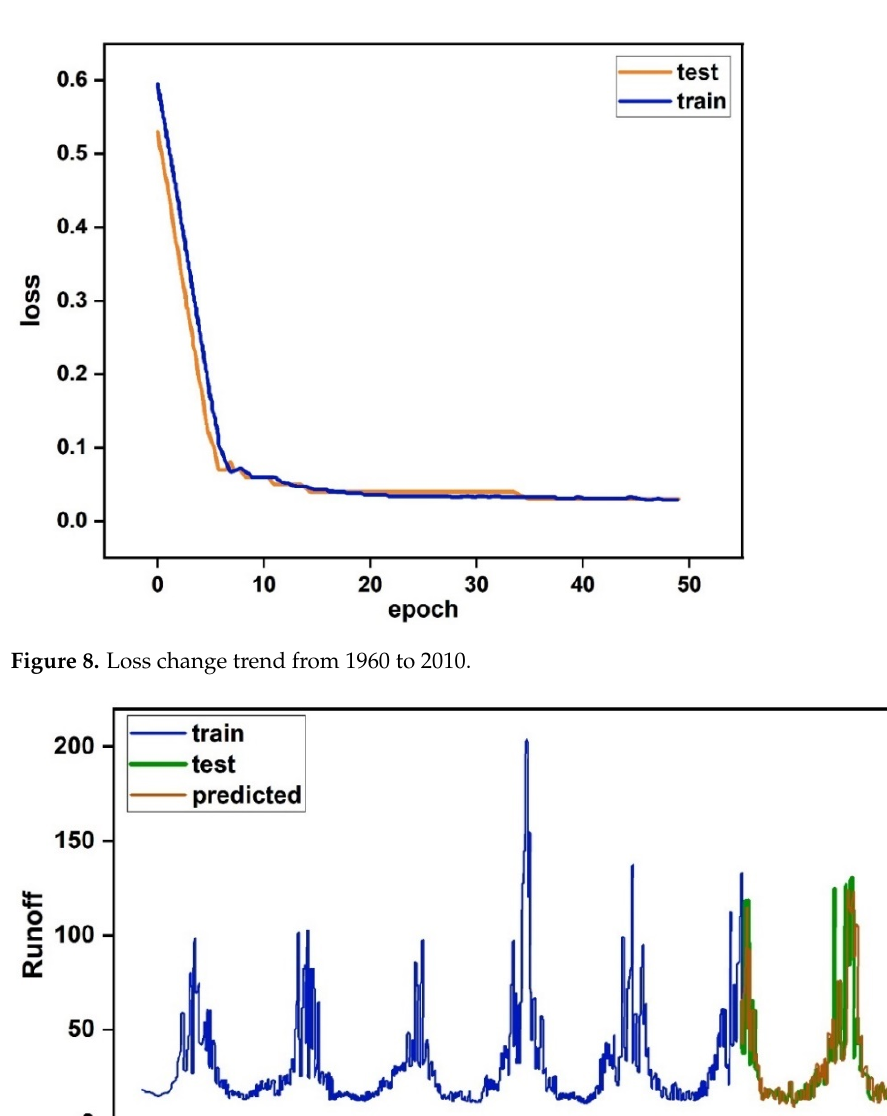
Figure 9. Comparison of prediction results (2008–2014).